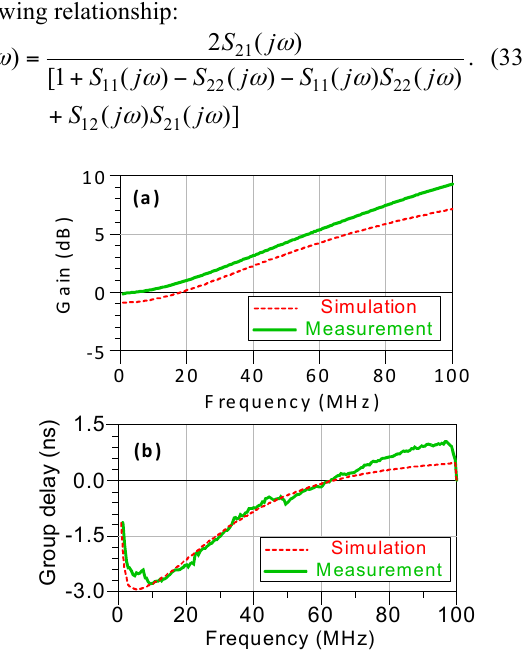
Figure 9: Comparisons of the simulated and measured frequency responses: (a) gain and (b) group delay